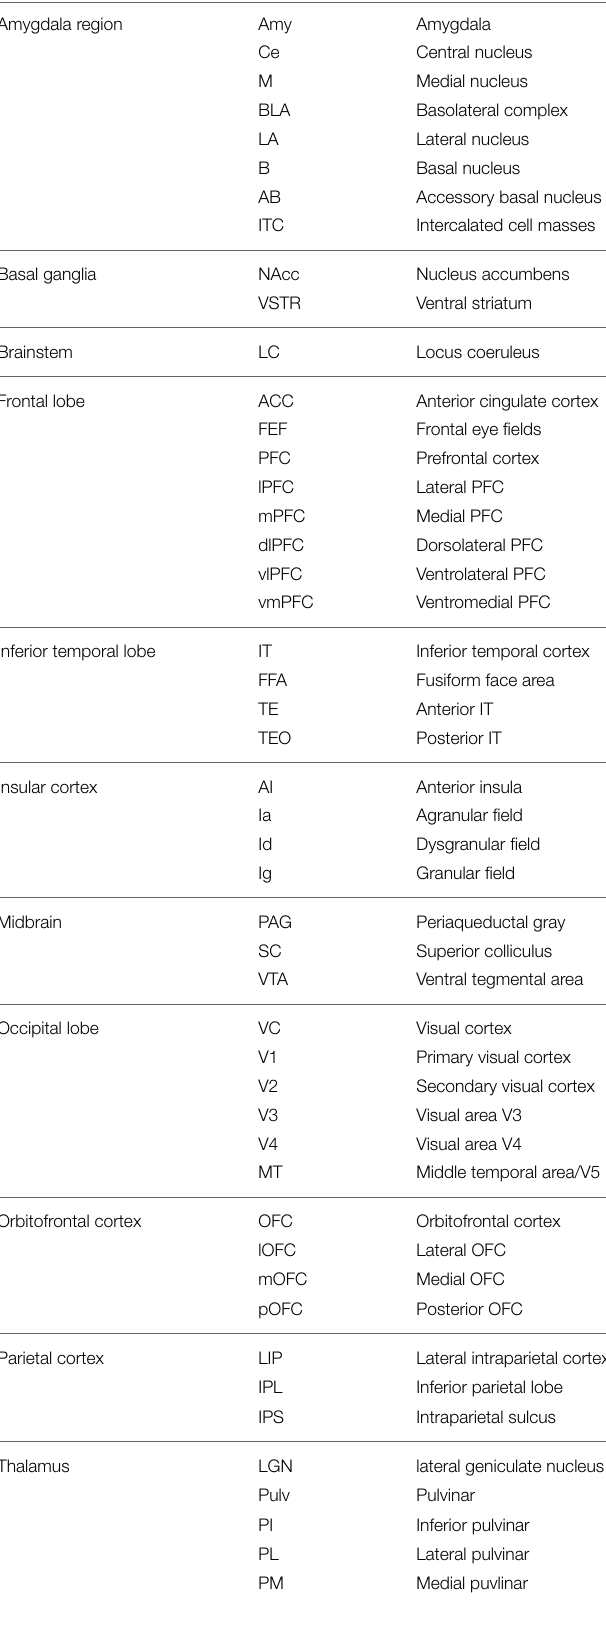
TABLE 1 | Abbreviations of anatomical primate brain regions and nuclei. Amygdala